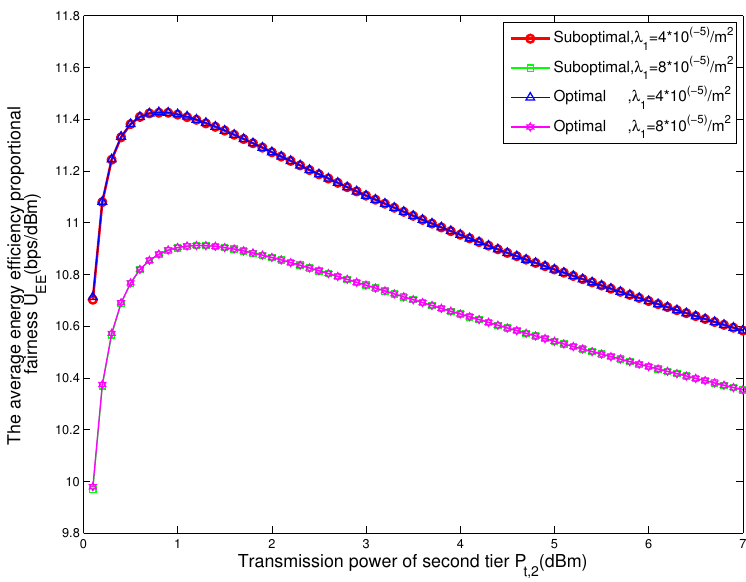
Figure 4. The mean energy efficiency proportional fairness with respect to the association probability of tier 2 obtained from the proposed suboptimal scheme and optimal two-dimension search scheme for different values of the transmit power of base stations